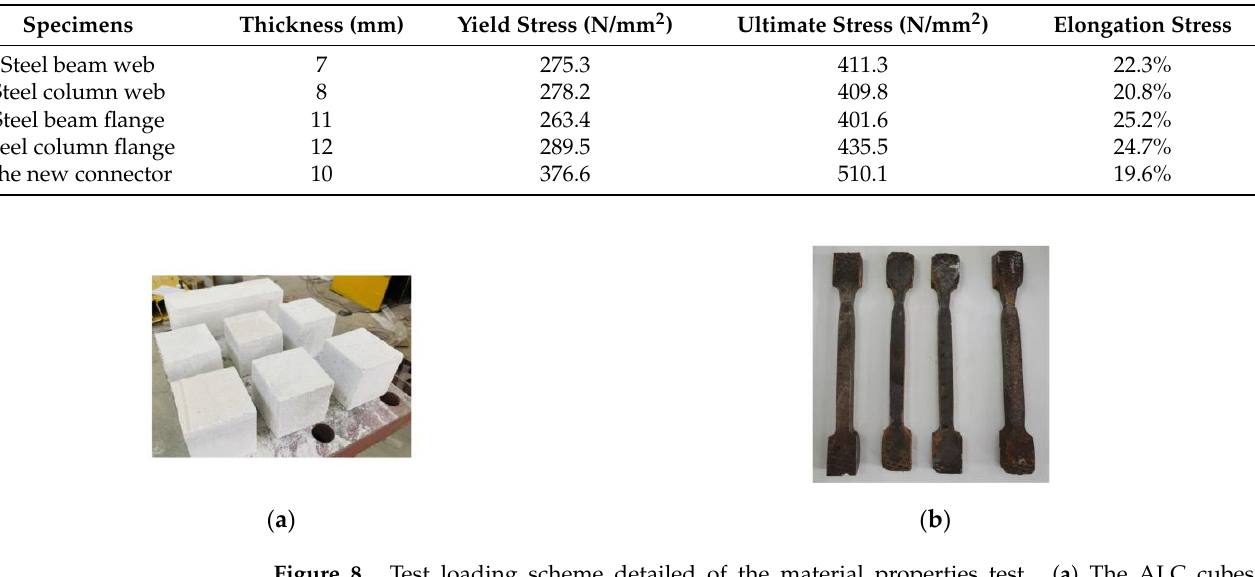
Table 3. Material properties index of steel.